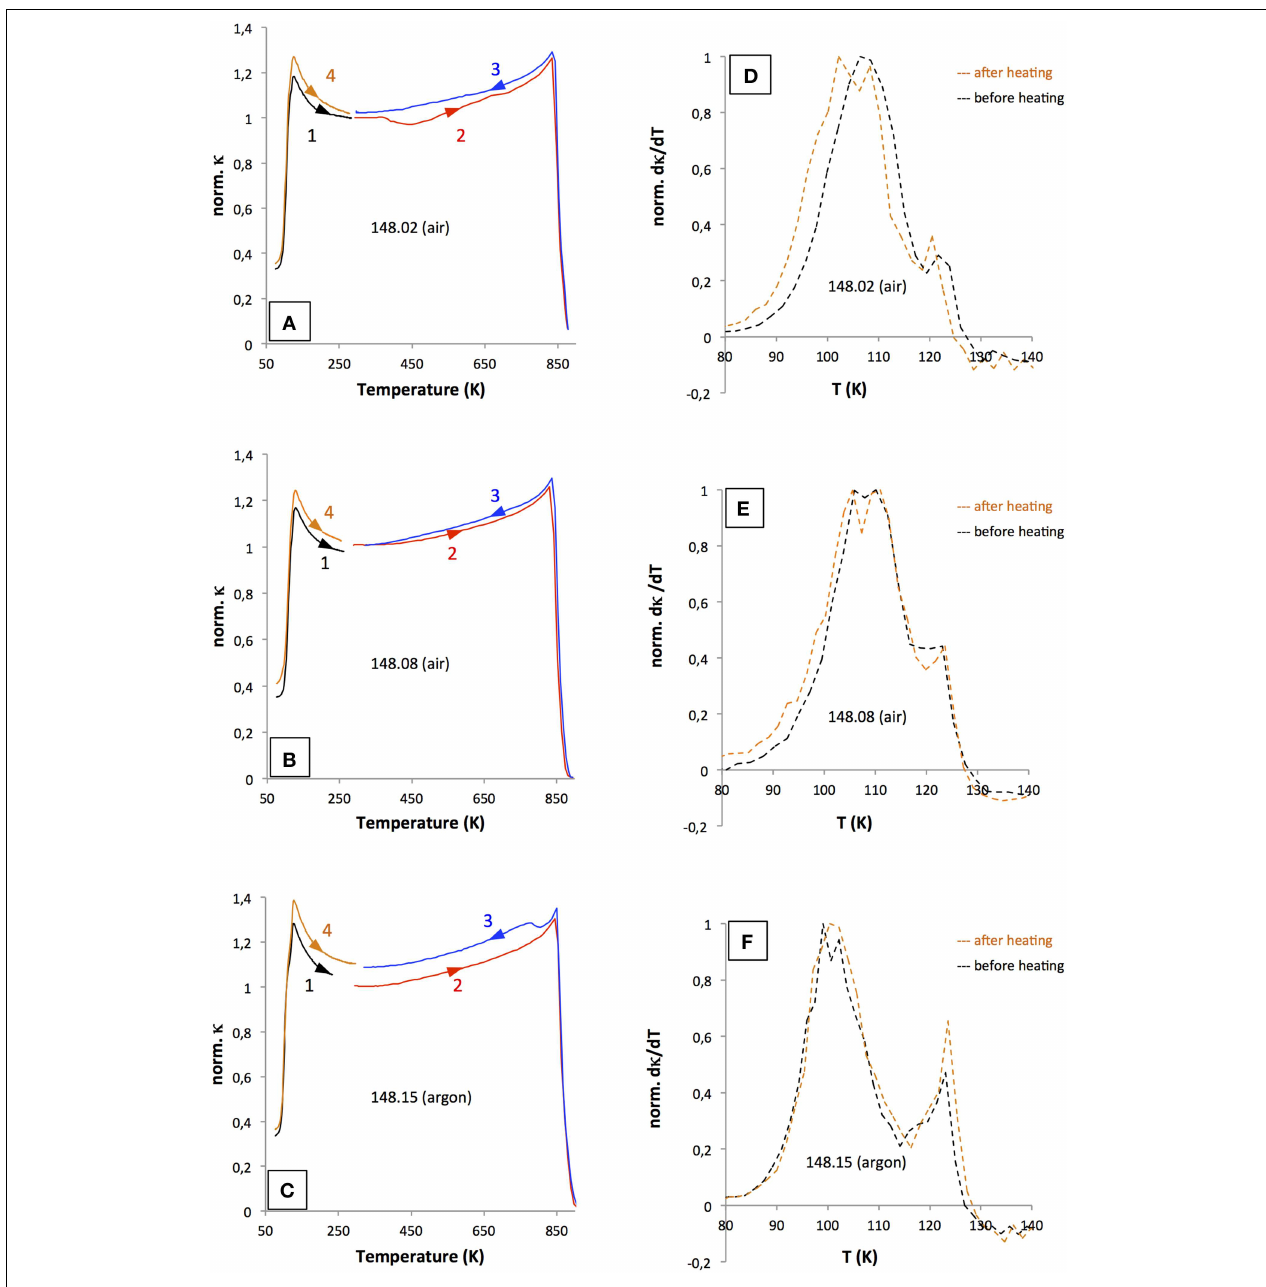
FIGURE 9 | Temperature dependent susceptibility for 148.02 (A), 148.08 (B), and (C) 148.15 experiments performed in air or in argon (data normalized to the room temperature value before heating). Step 1: low temperature measurement from 77